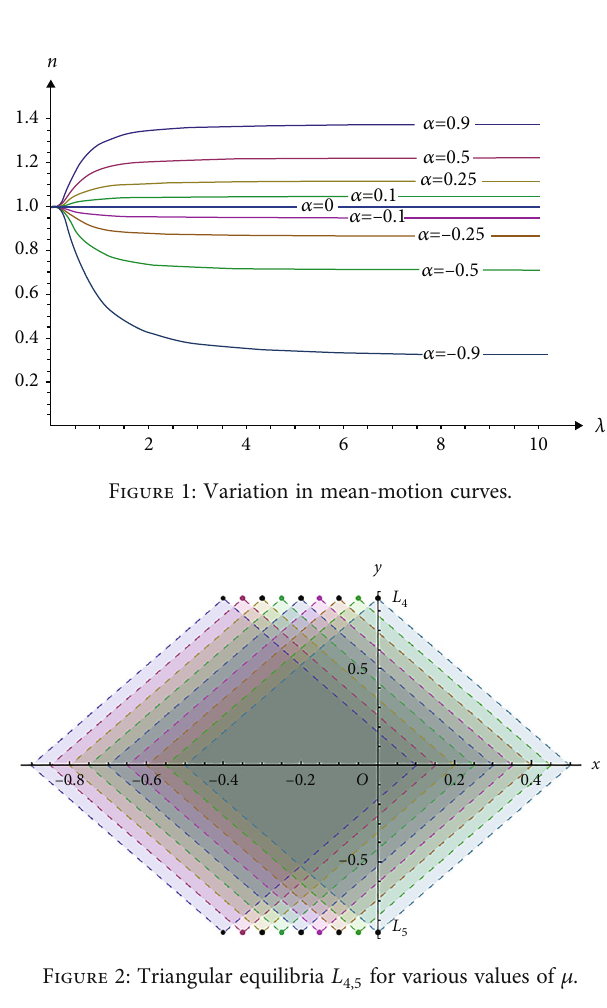
4,5 for various values of